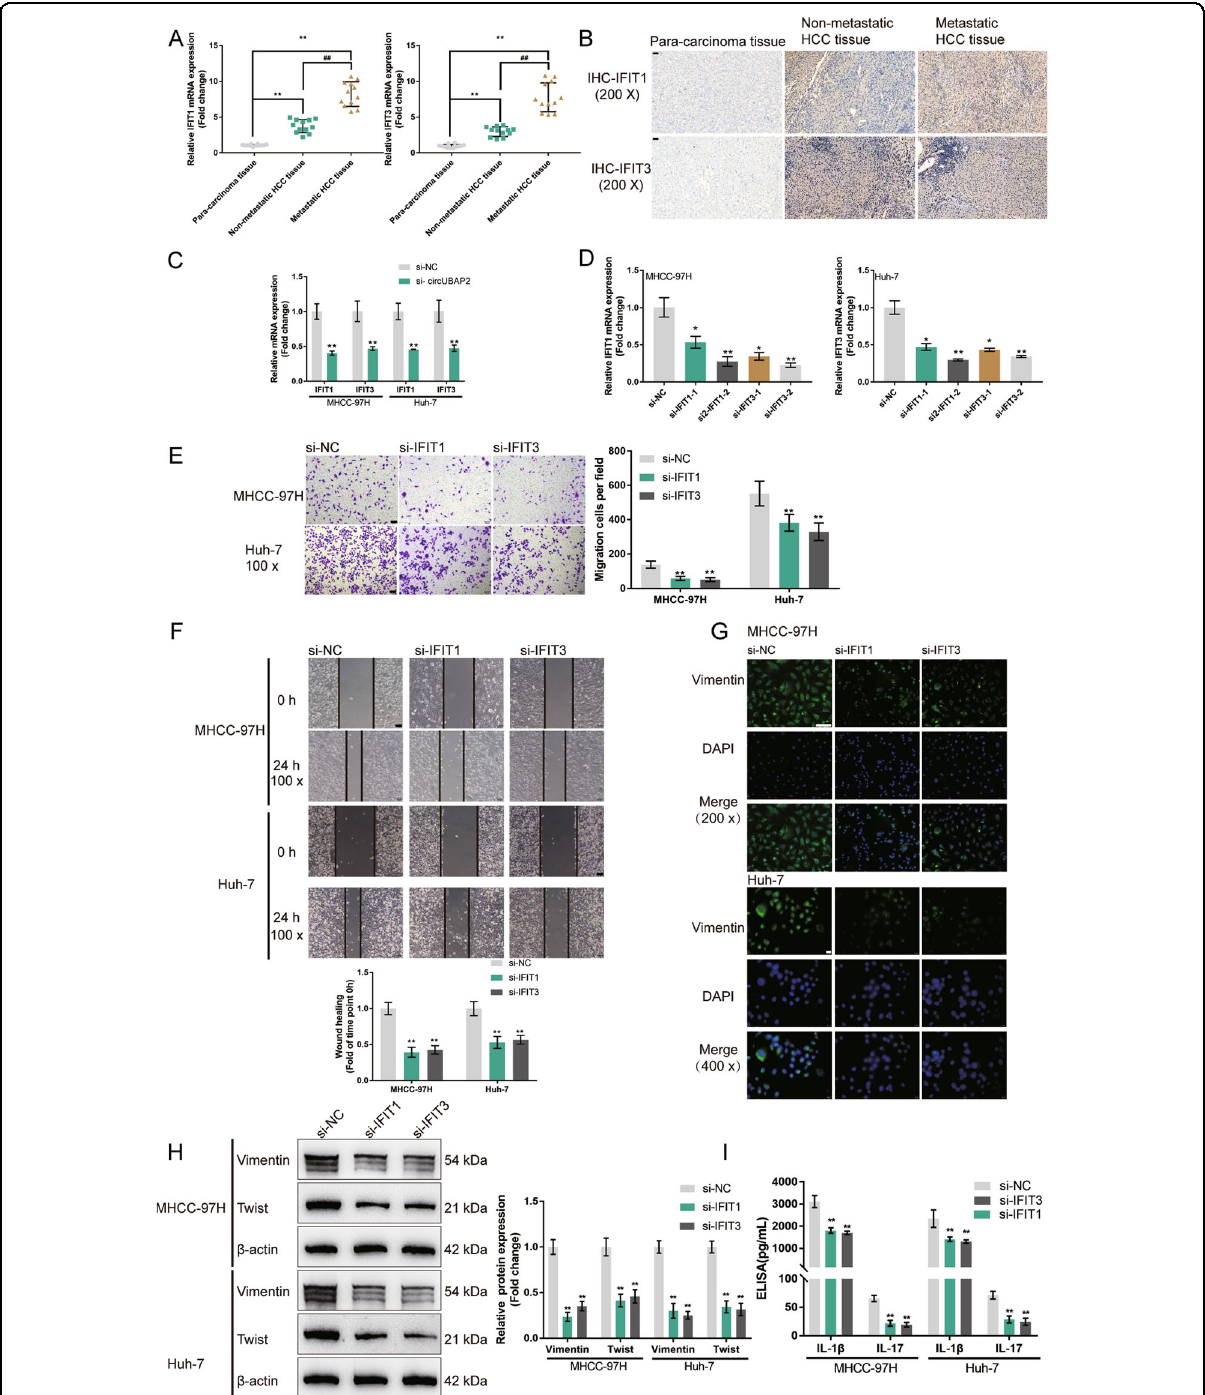
Fig. 5 Effects of IFIT1/IFIT3 on HCC cell phenotype. A The mRNA expression of IFIT1 and IFIT3 was examined in 12 cases of nonmetastatic HCC tissues, metastatic HCC tissues, and para-carcinoma tissues by real-time PCR. B The protein contents and distribution of IFIT1 and IFIT3 were examined in nonmetastatic HCC tissues, metastatic HCC tissues, and para-carcinoma tissues by IHC staining. C MHCC-97H and Huh-7 cells were transfected with si- circUBAP2 and examined for the mRNA expression of IFIT1 and IFIT3 by real-time PCR. D IFIT1 or IFIT3 silencing was achieved in MHCC-97H and Huh-7 cells by transfecting small interfering RNA targeting IFIT1 or IFIT3 (si-IFIT1-1 or si-IFIT1-2; si-IFIT3-1 or si-IFIT3-2). Si-NC was transfected as a negative control. The transfection ef fi ciency was con fi rmed by real-time PCR and si-IFIT3-1 and si-IFIT1-2 were chosen for further experiments due to better transfection ef fi ciency. Next, MHCC-97H and Huh-7 cells were transfected with si-NC, si-IFIT1, or si-IFIT3, and examined for E Cell migration by Transwell assay; F Cell migration by wound healing assay; G Cellular protein content and distribution of Vimentin was examined by IF staining; H The protein levels of Vimentin and Twist was examined by Immunoblotting; I The concentrations of IL-1 β and IL-17 in the culture medium by ELISA. * P <0.05, ** P <0.01, compared with the si-NC